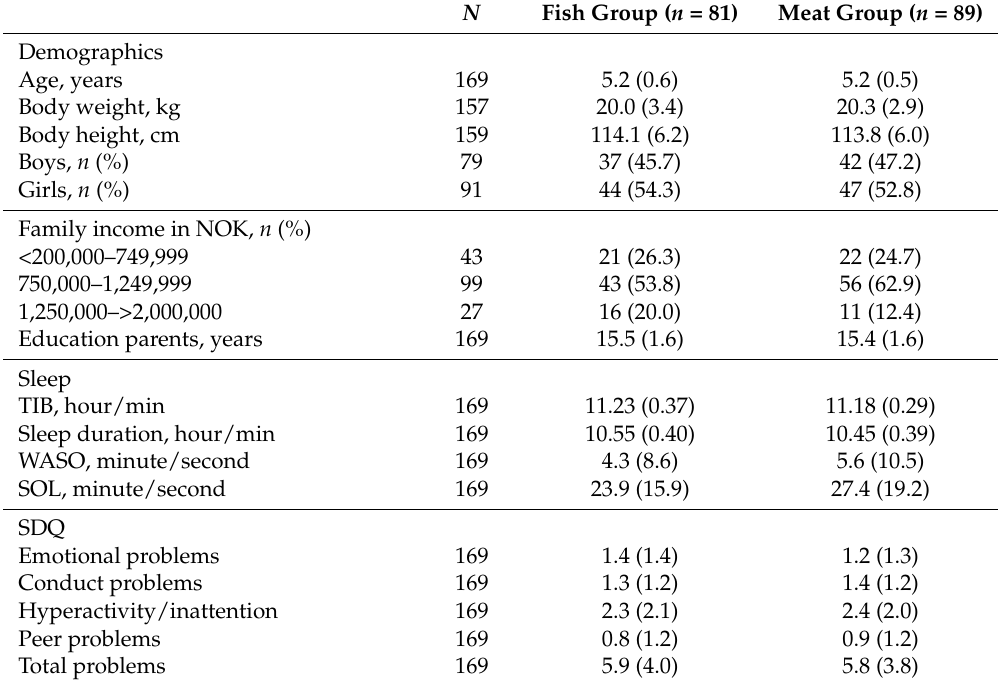
Figure 1. Overview of the study population. SDQ, Strengths and Difficulties Questionnaire. Table 1. Characteristics of the participants at baseline 1 .